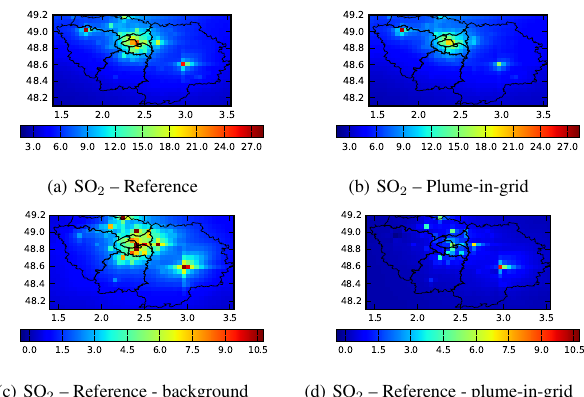
Fig. 6. SO 2 concentrations over Paris region averaged over the sim- ulation period, at ground level. (a) and (b) show the concentrations for the reference and the plume-in-grid simulation, respectively, in µgm − 3 . (c) shows the differences between mean ground concen- trations with and without point sources for the reference simulation. (d) shows the differences between mean ground concentrations with and without plume-in-grid